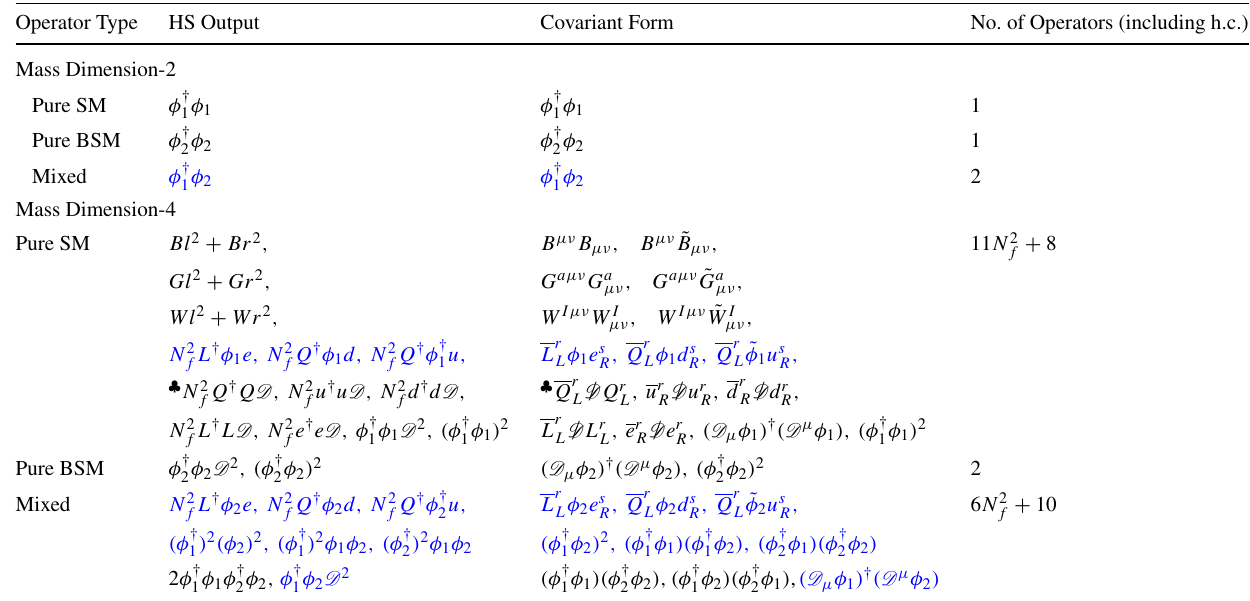
Table 4 2HDM: renormalizable operators as Hilbert Series output and their covariant form. Coefficients of each operator (which appear as functions of N f ) give the number of all possible operators with the same structure. The operators in blue have distinct hermitian conjugates which we have not written explicitly. Here, I = 1,2,3 are SU ( 2 ) indices; a =1,…,8are SU ( 3 ) indicesand r , s = 1 , 2 ,..., N f areflavourindices